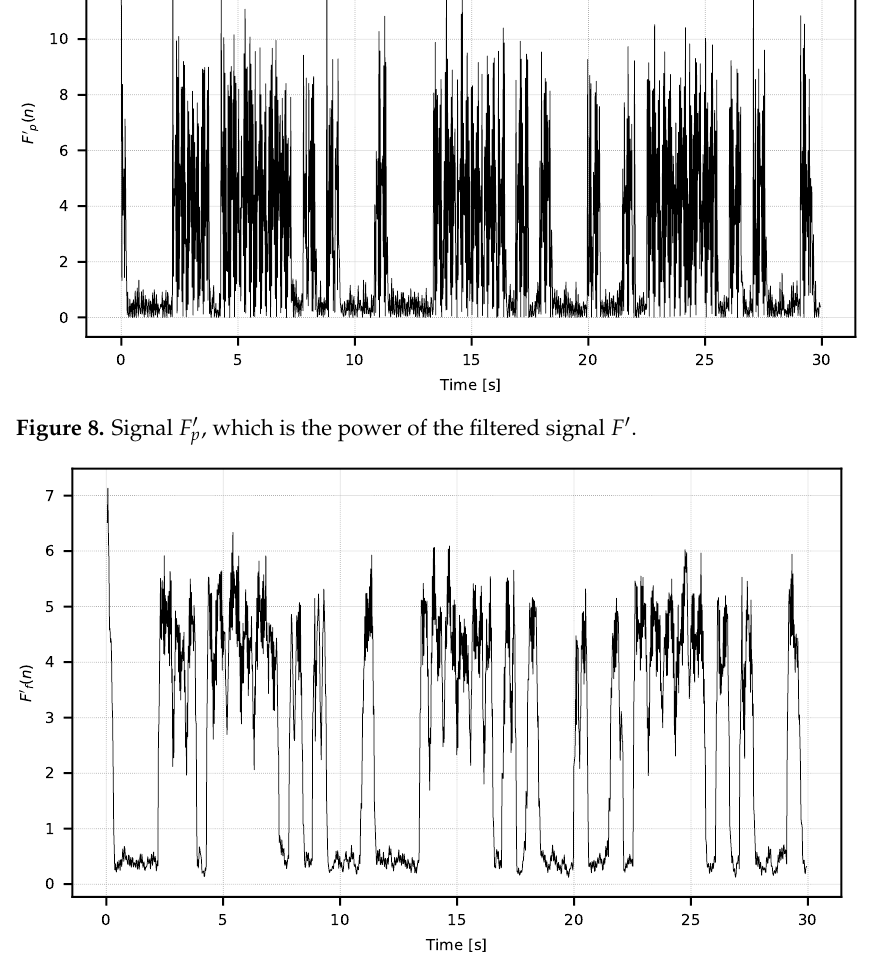
Figure 9. Signal F (cid:48) averaged with window size w (cid:48) = f